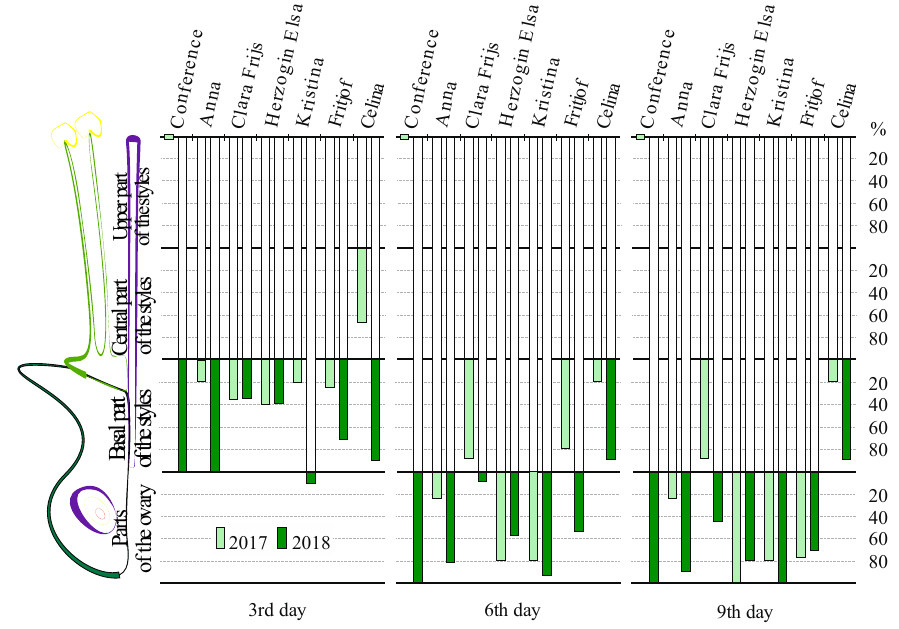
Figure 7. The dynamics of pollen tube growth through certain pistil parts (3, 6 and 9 DAP) of cultivar “Celina” in different combinations of pollination in 2017 and 2018.